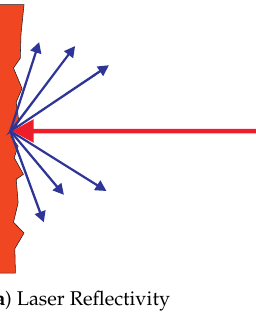
Figure 2. Laser reflectivity in real experiments. The majority of surfaces reflect the laser beam diffusely in all directions.